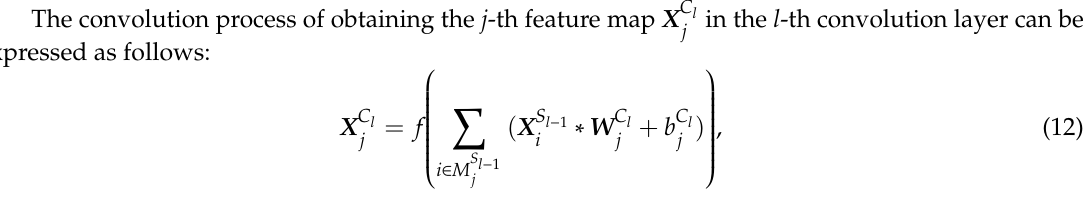
Figure 5. Illustration of different CNN components: ( a ) Convolution layer; ( b ) ReLU unit and ( c ) Figure5. IllustrationofdifferentCNNcomponents: ( a )Convolutionlayer;( b ) ReLU unitand( c pooling layer.